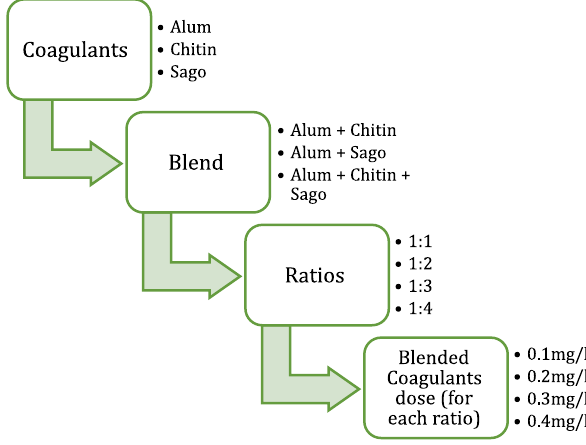
Fig. 1 Flowchart of the methodology adopted for blended coagulants